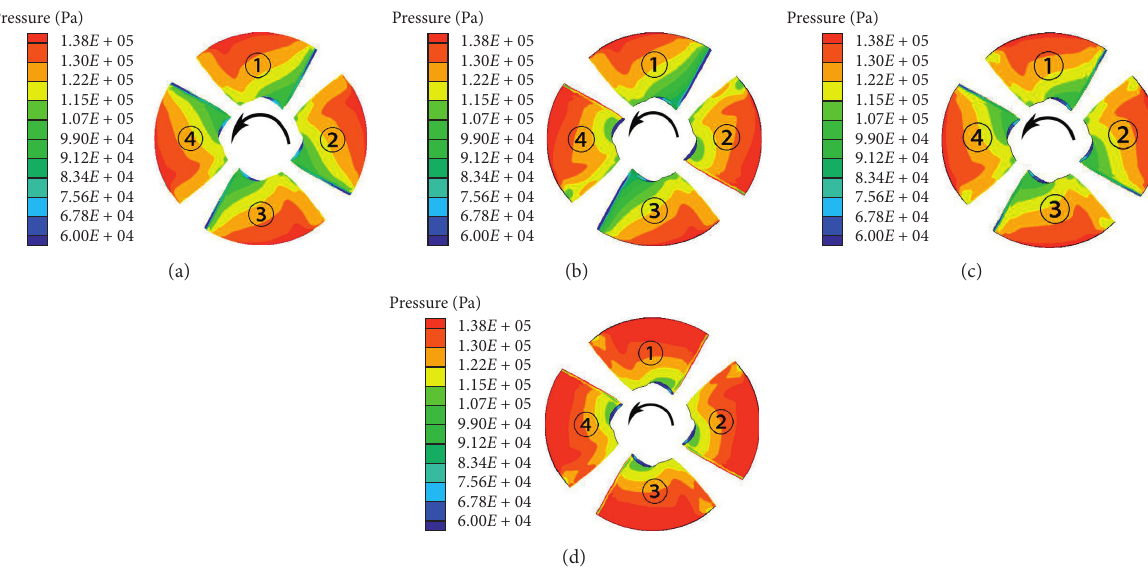
Figure 9: Pressure distribution of impeller pressure surface in different schemes ( Q � Q Scheme IV.